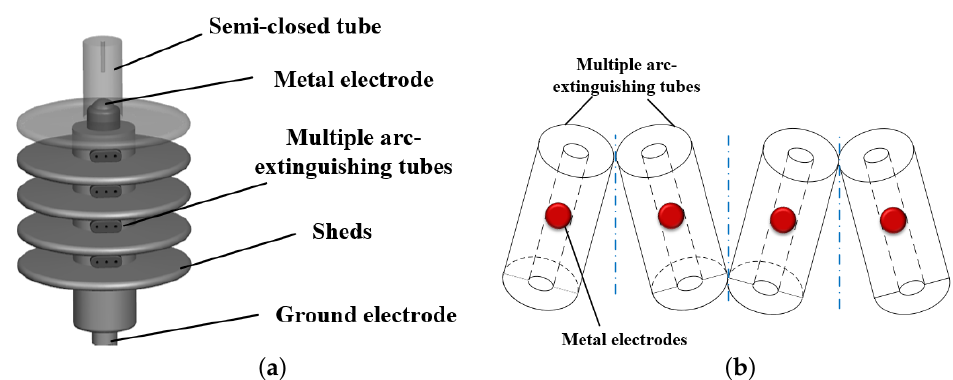
Figure 1. Structural schematic diagram of semi-closed multi-compression tube structures (SMTS): ( a ) The appearance of SMTS. ( b ) The internal structure of the multi-compression